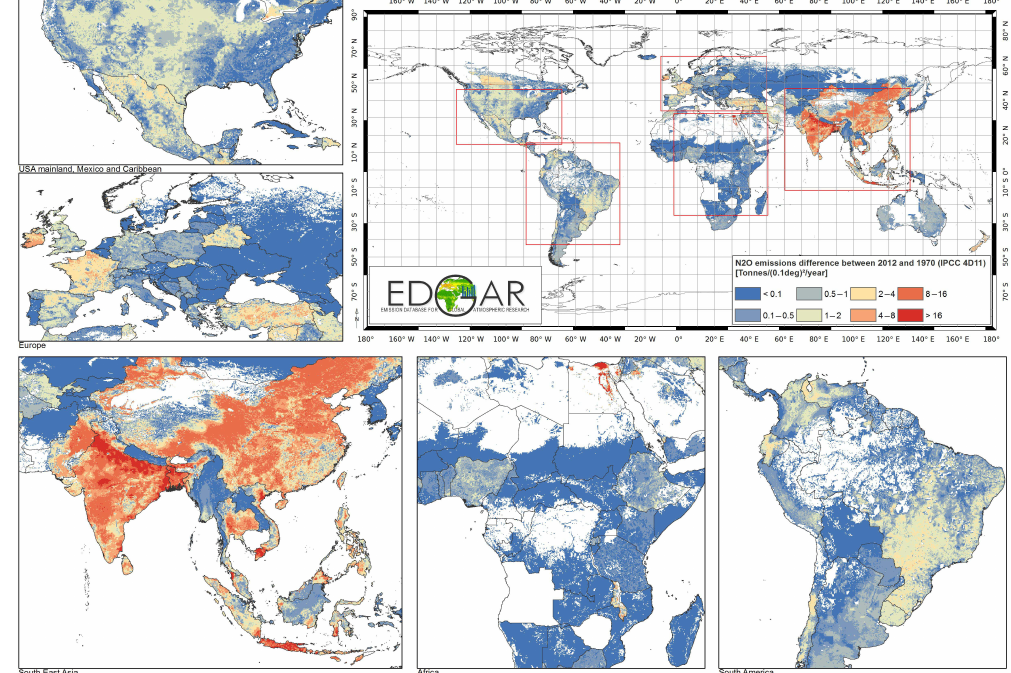
Figure 16. Difference between 2012 and 1970 in N 2 O emissions from fertiliser use on agricultural soils.